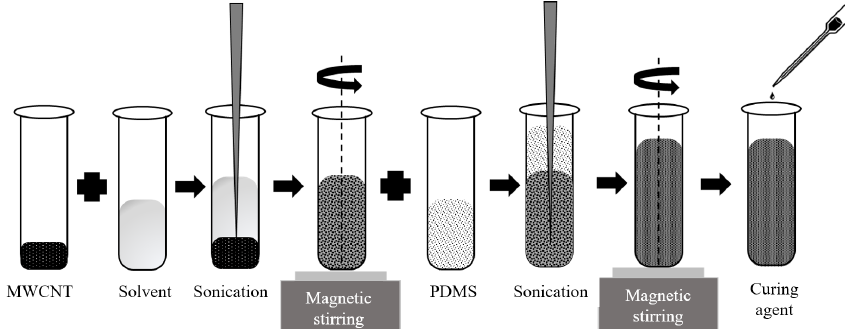
Figure 1. Nanocomposite synthesis process steps.